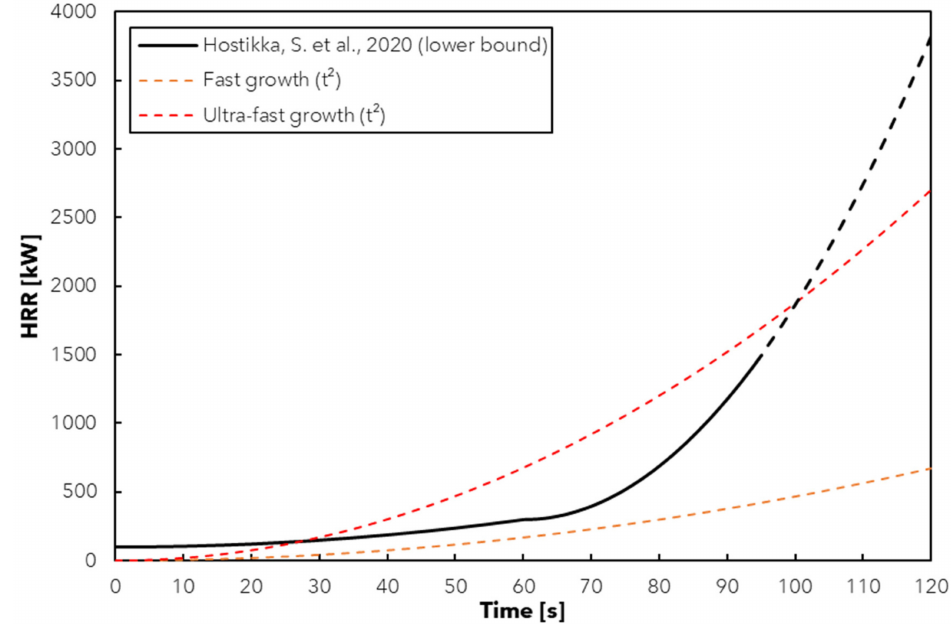
Figure 9. HRR relationship adopted for the zone modelling from Hostikka et al. [35]. Dashed black line indicates modelling assumption that the HRR grows beyond 1500